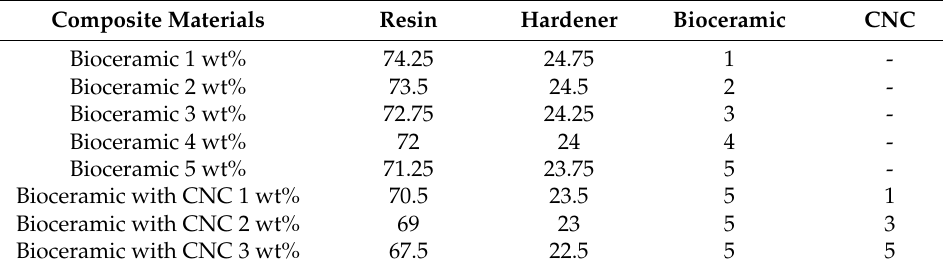
Figure 1. Synthesis of composite material. Table 1. Composite materials weight ratio.